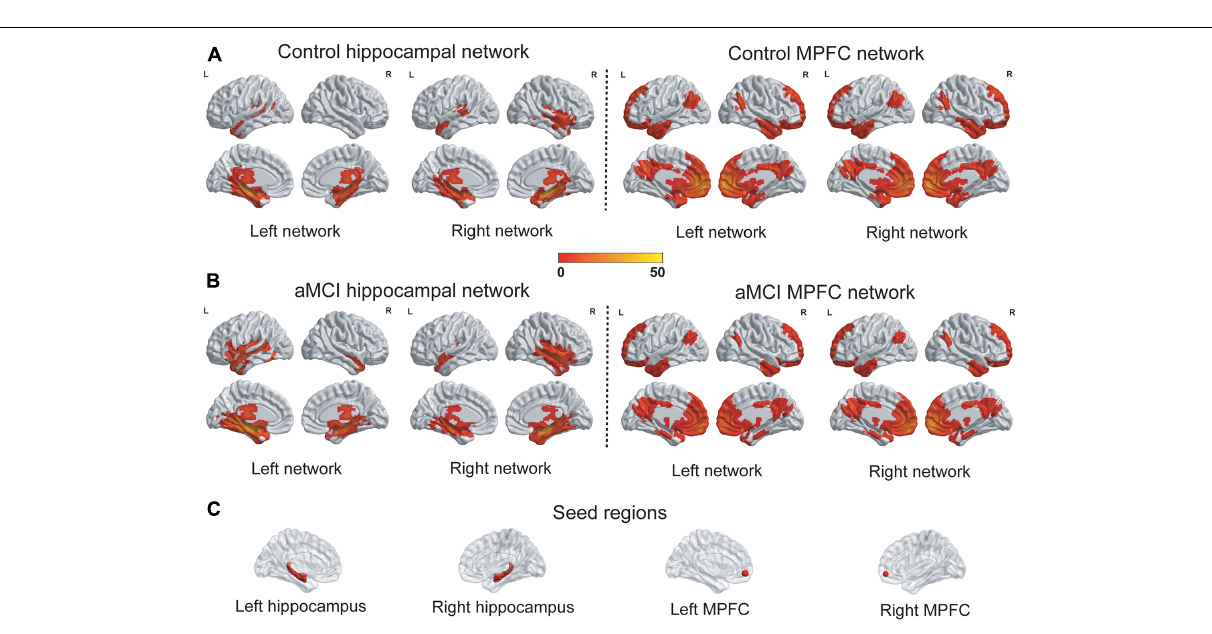
FIGURE 2 | The patterns of the hippocampal networks and the MPFC networks. (A,B) The hippocampal networks and the MPFC networks were identified in the control group and the aMCI group. A qualitative visual inspection of the FC revealed that the majority of clusters were highly consistent between the groups. The statistical thresholds were set at a corrected P < 0.01, which were determined by a Monte Carlo simulation. The color bar is presented with t values. (C) The seed regions for networks were depicted. L, left; R, right; MPFC, medial prefrontal cortex; FC, Functional connectivity.